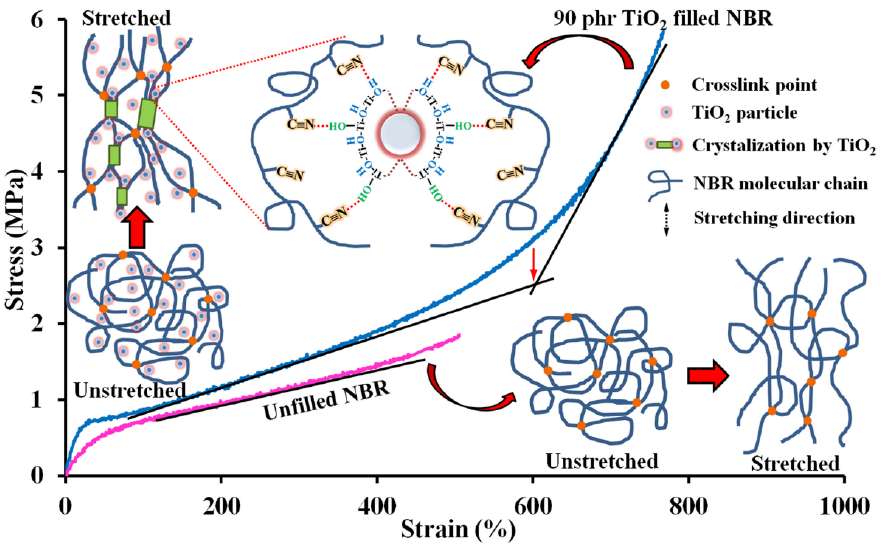
Scheme 2. Schematic illustration of the proposed reinforcing mechanism and strain-induced crys- tallization in TiO 2 -filled NBR